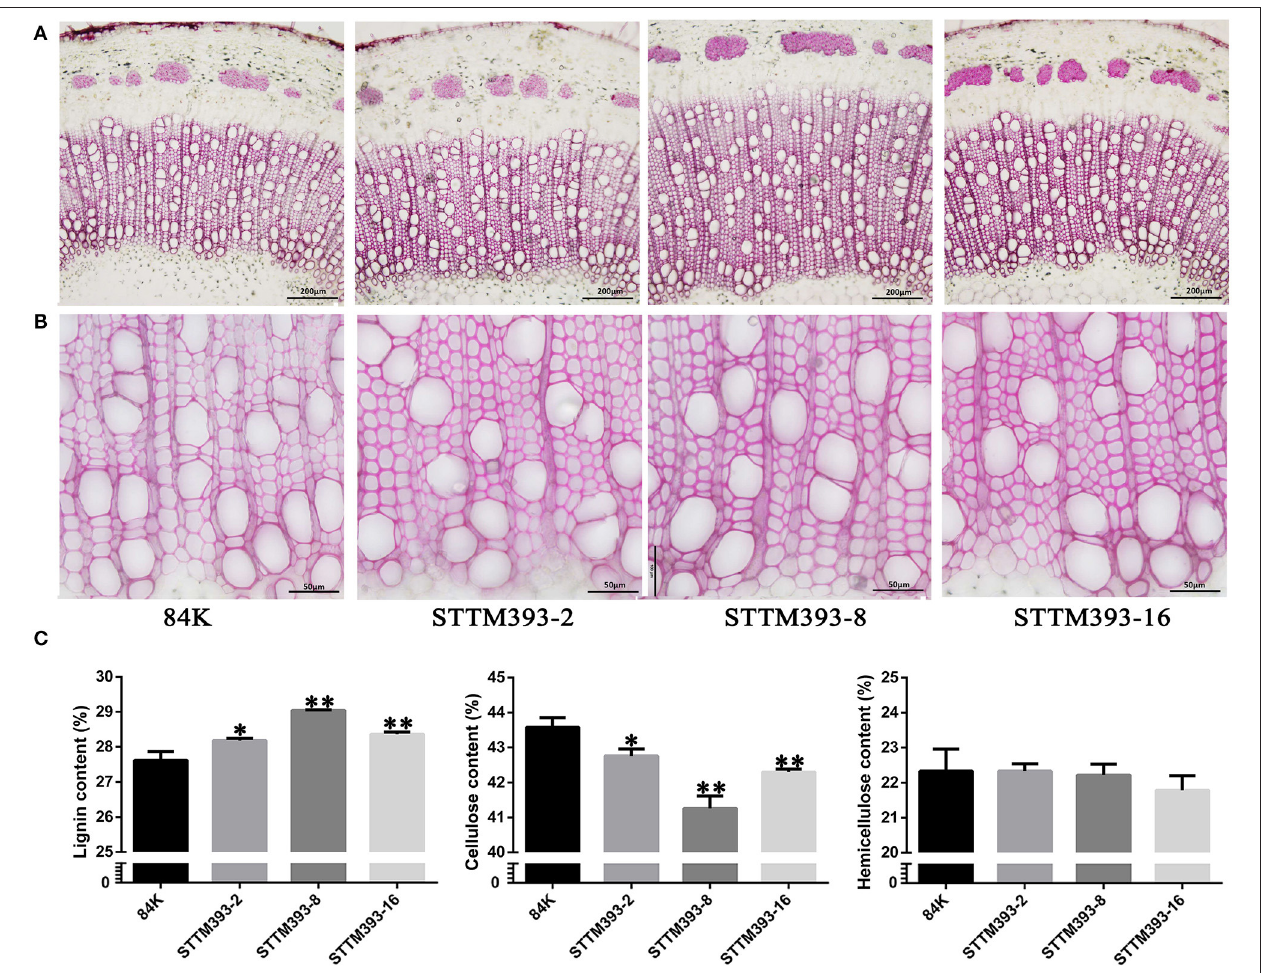
FIGURE 3 | The chemical composition analysis in STTM393 transgenic plants. (A) The cross-sections of the 15th internode of 6-month-old STTM393 and 84K control plants stained by phloroglucinol-HCl, Bar = 200 µ m. (B) The magnified xylem region of (A) , Bar = 50 µ m. (C) The lignin, cellulose, and hemicellulose content of stem from 16th to 40th internodes of 6-month-old STTM393 lines and 84K control plants. The bars represent means ± SD ( n > 6). ** P ≤ 0.01, *0.01 < P ≤ 0.05.